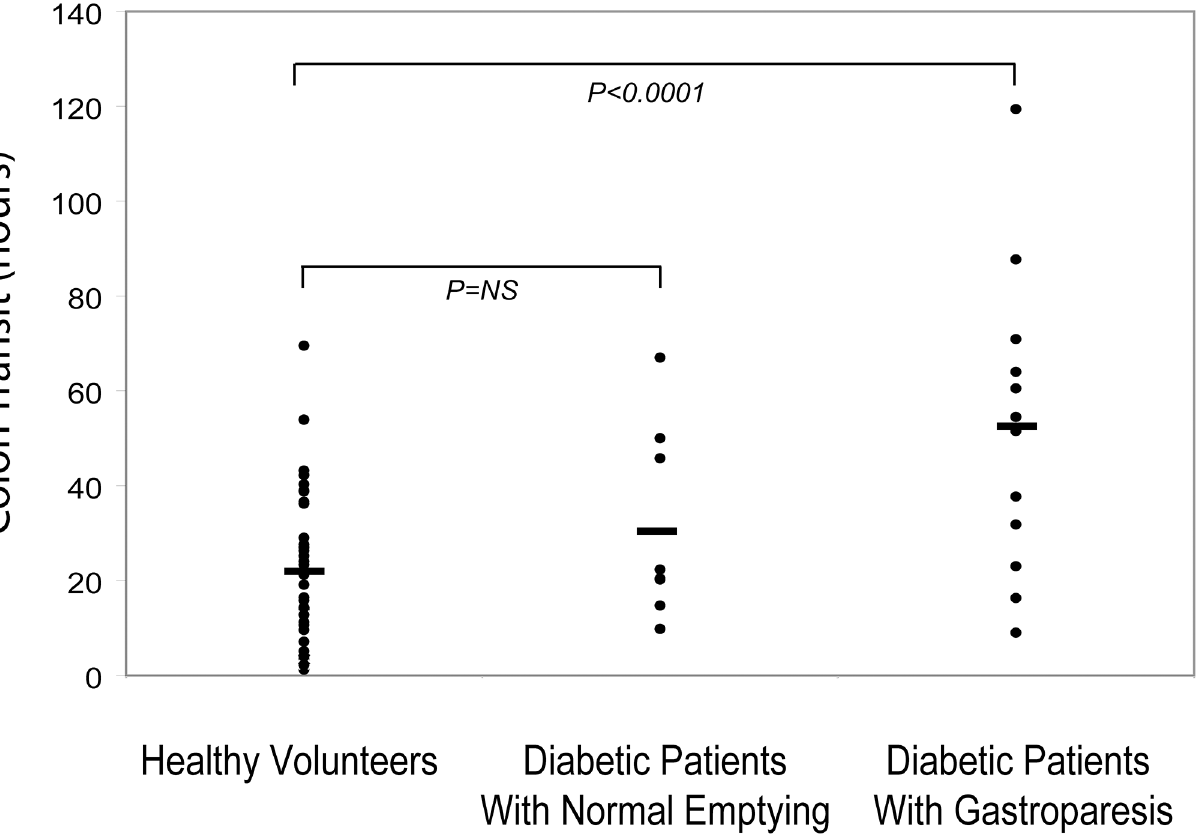
Fig 2. Colon Transit Times in Relation to Gastric Emptying. Colon transit times are compared in individual healthy volunteers, diabetics with normal gastric emptying, and diabetics with gastroparesis. Gastroparesis patients exhibited significant prolongation of colon transit versus healthy subjects (P < 0.0001), while diabetics with normal gastric emptying showed colon transit times that were not different from healthy controls (P =